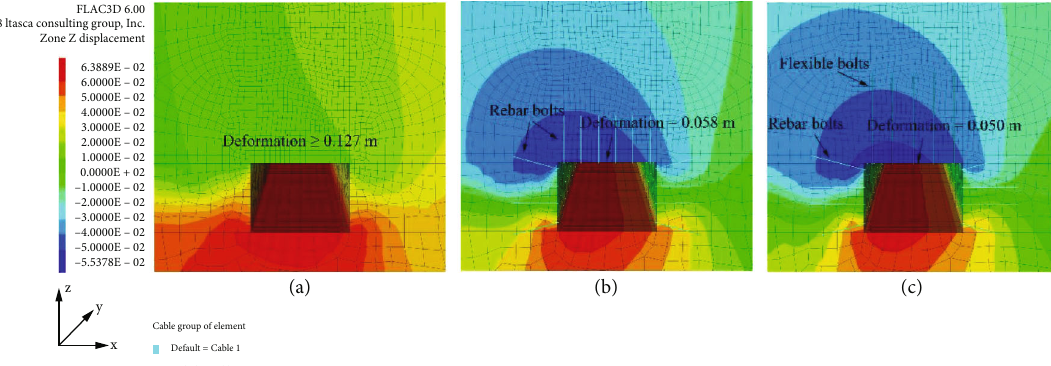
Figure 11: Comparison of vertical deformation of roadway under (a) unsupported, (b) original support scheme, and (c) TADL support